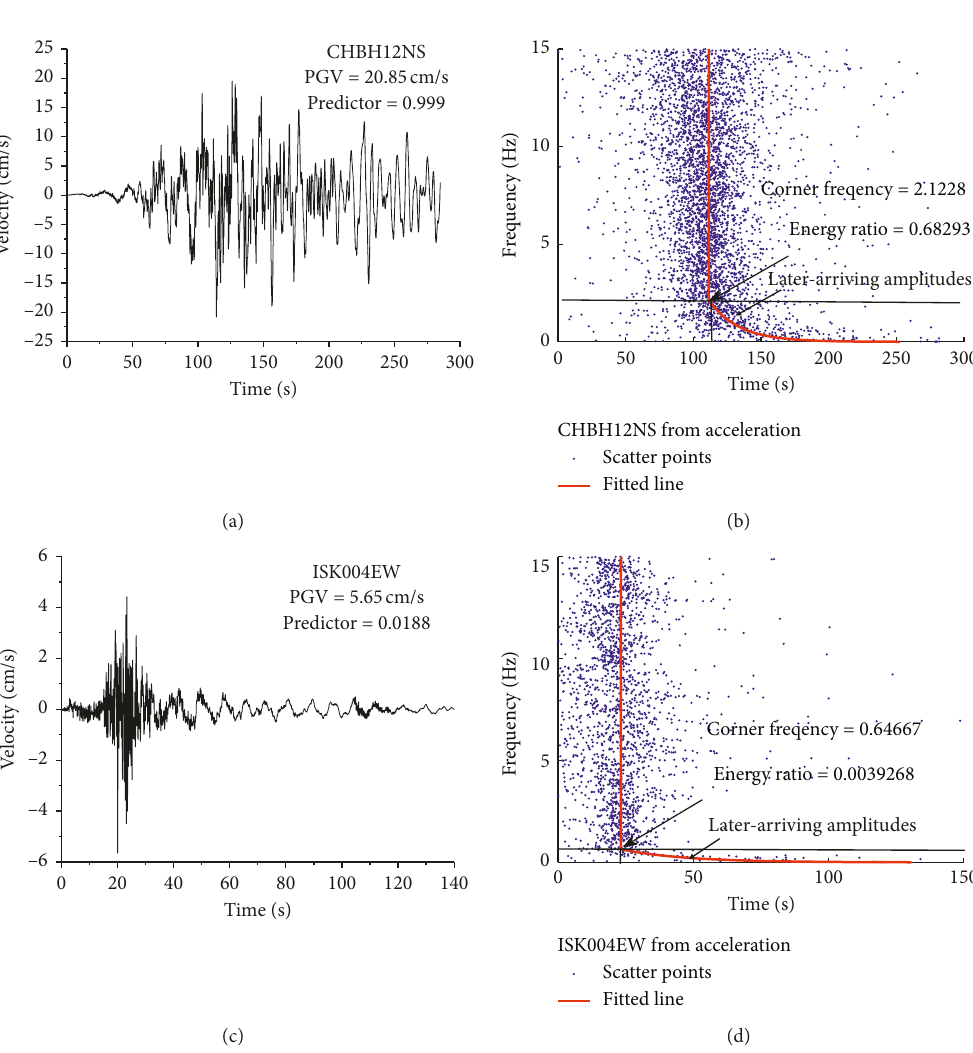
Figure 3: Comparison of envelope delays for the identified long-period motion of CHBH12NS from Tohuku, M9, earthquake and non- long-period motion of ISK004EW from Niigataken, Chuetsu-oki, M6.8, earthquake. The fitted line is derived by fitting the piecewise function to actual envelop delays in the sense of the least squares algorithm considering the weight function. (a) and (c) velocity-time series; (b) and (d) envelope delays including the fitted line. Note that the lower-right quadrant in (b) and (d) shows the later-arriving long-period amplitudes involved in the calculation of the energy